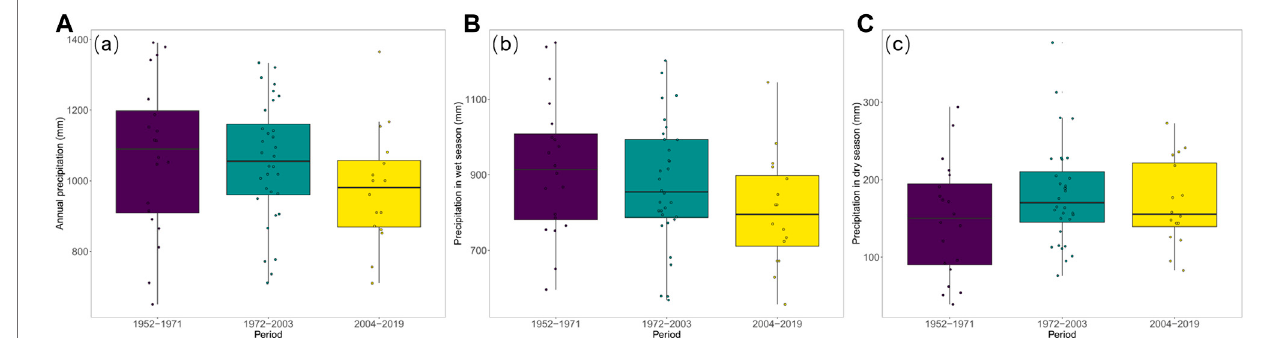
FIGURE 6 | Box plots for annual (A) , wet season (B) , and dry season (C) precipitation in 1952 – 1971, 1972 – 2003, and 2004 – 2019 periods. Lower, middle, and upper lines of box indicate fi rst quantile, median, and third quantile of the data, respectively. Vertical line indicates values within 1.5 interquartile range below the lower quartile and above the upper quartile. Dots are yearly data.